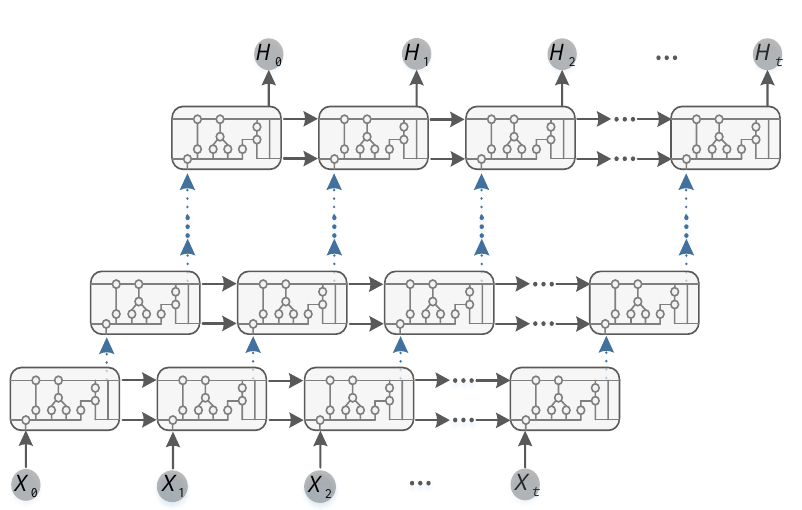
Figure 1. M-LSTM Network Model.